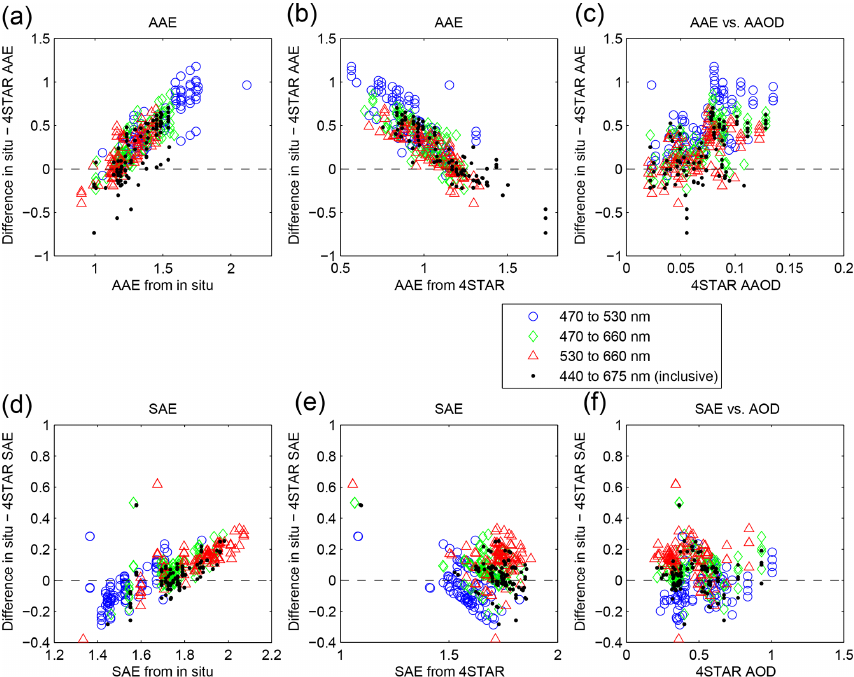
Figure 9. Difference between AAE measured in situ versus retrieved from 4STAR (in situ – 4STAR) as a function of (a) in situ AAE, (b) 4STAR AAE, and (c) 4STAR AAOD. The bottom panels show the same but for SAE differences versus (d) in situ SAE, (e) 4STAR SAE, and (f) 4STAR AOD. Note that multiple individual points for one instrument (profiles or sky scans) may be shown for comparison cases which included more than one sample per instrument (i.e., × marks in Fig. 8). This is an indication of the variability within a specific case.